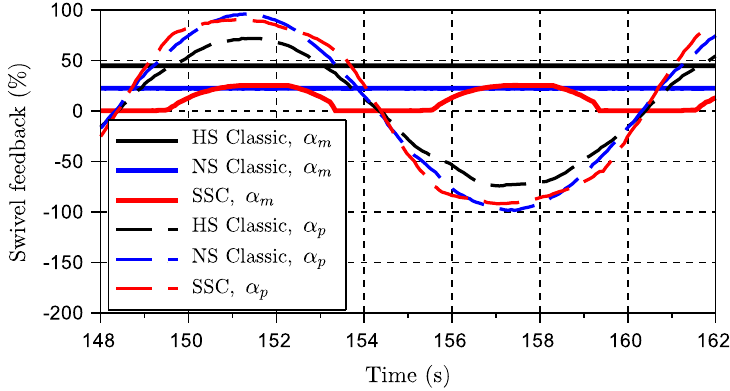
Figure 22. Pump and motor displacement settings for scenario 2 (0% for the motor means maximum displacement).